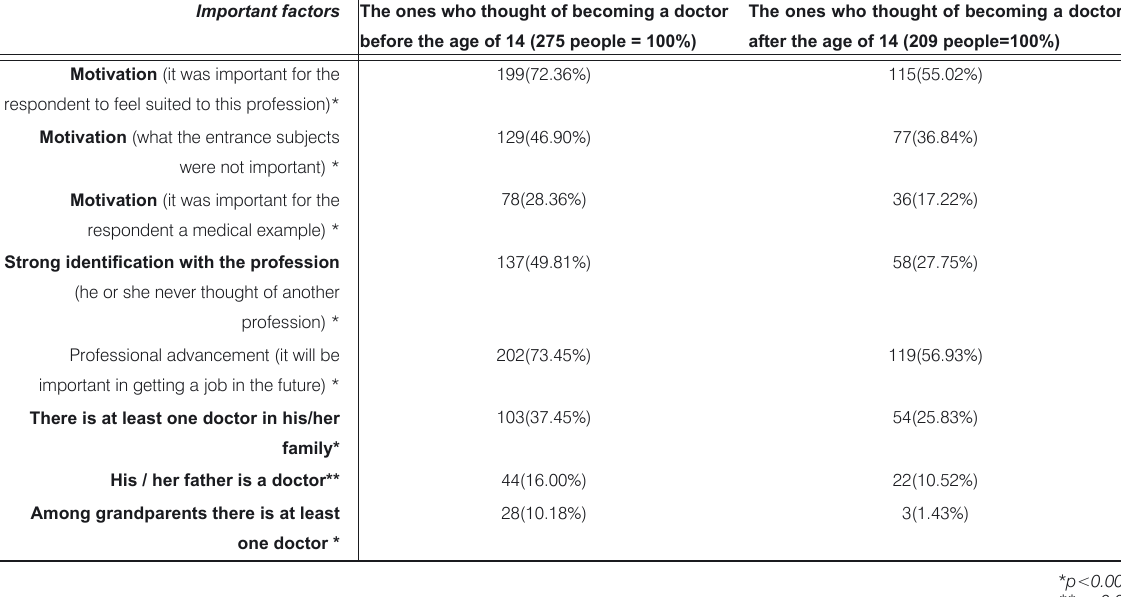
Table 4. The most significant differences between the students based on their age of having thought of medical profession first